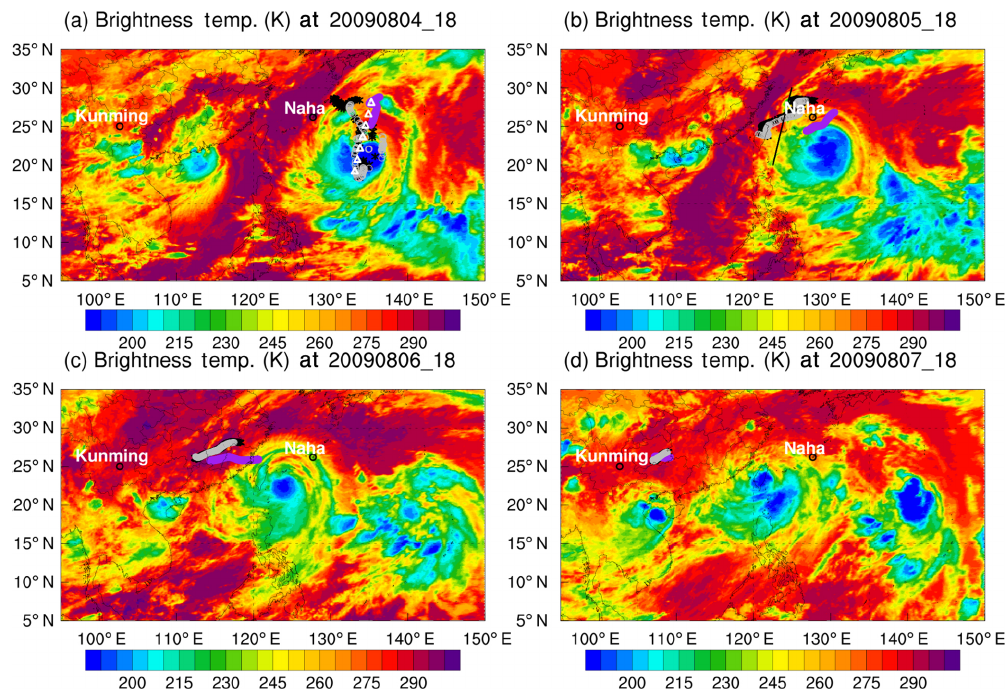
Figure 7. Brightness temperature (K) from the IR channel of FY-2D on (a) 4 August, 18:00UTC; (b) 5 August, 18:00UTC; (c) 6 August, 18:00UTC; and (d) 7 August 2015, 18:00UTC, with air parcels’ locations based on backward trajectories (grey circles: ERA5 diabatic; black asterisk: ERA5 kinematic; purple circles: ERA-Interim diabatic). White triangles mark the MLS tracks (a) and the black line denotes the ground track of CALIPSO (b)